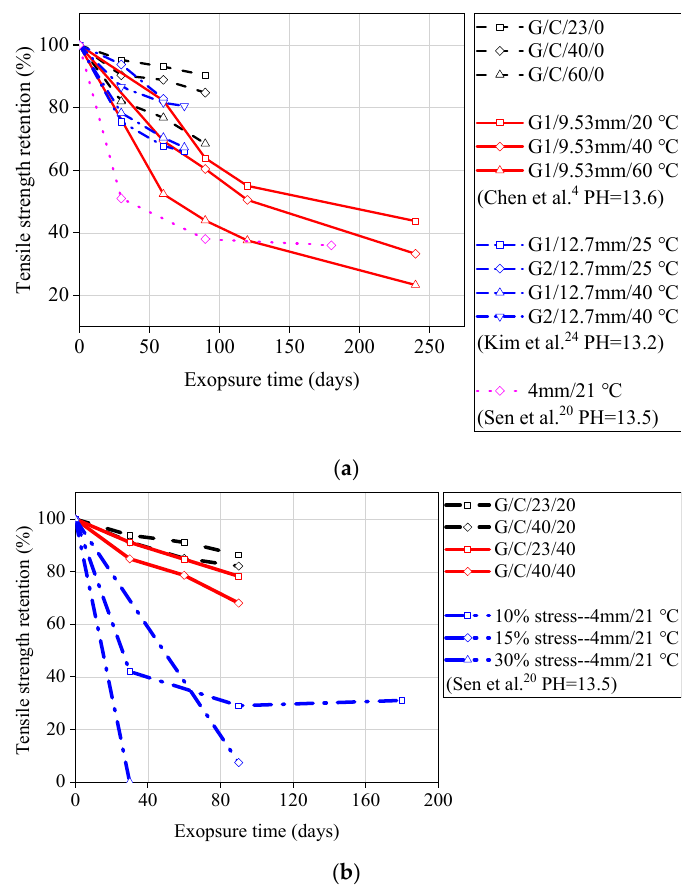
Figure 6. Comparison of experimental data (GFRP bars exposed to concrete pore solutions solution) from this study and previous literature: ( a ) unstressed bars; ( b ) stressed bars.